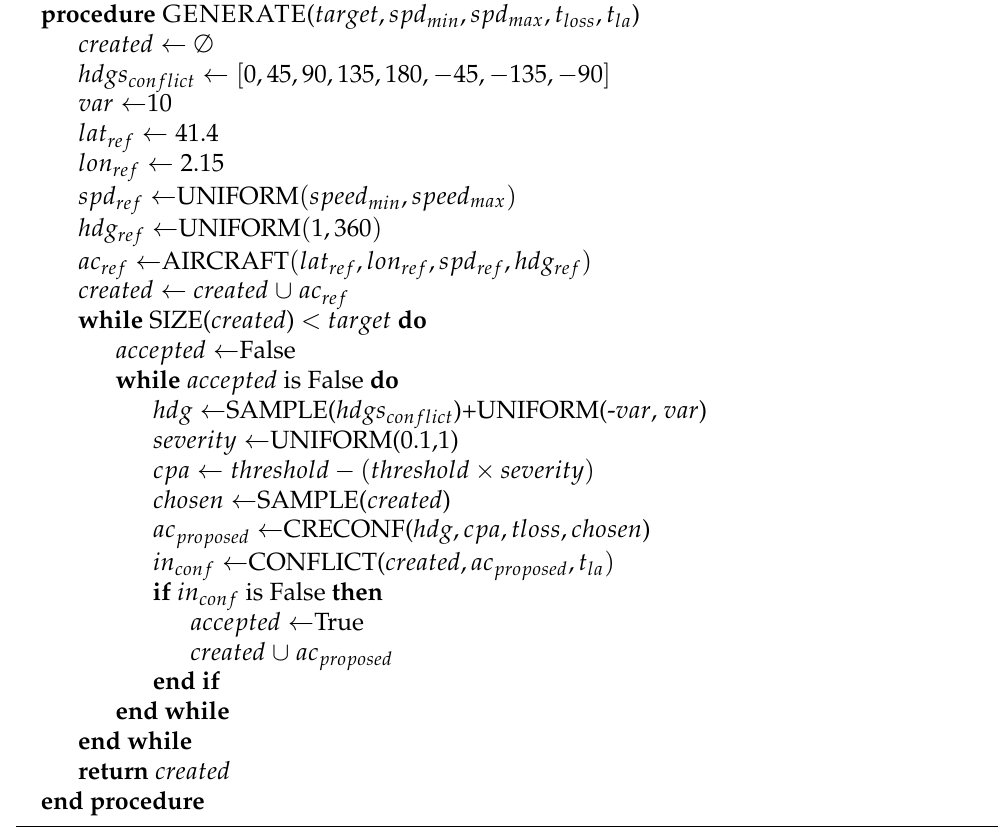
Algorithm 1 Data Generation